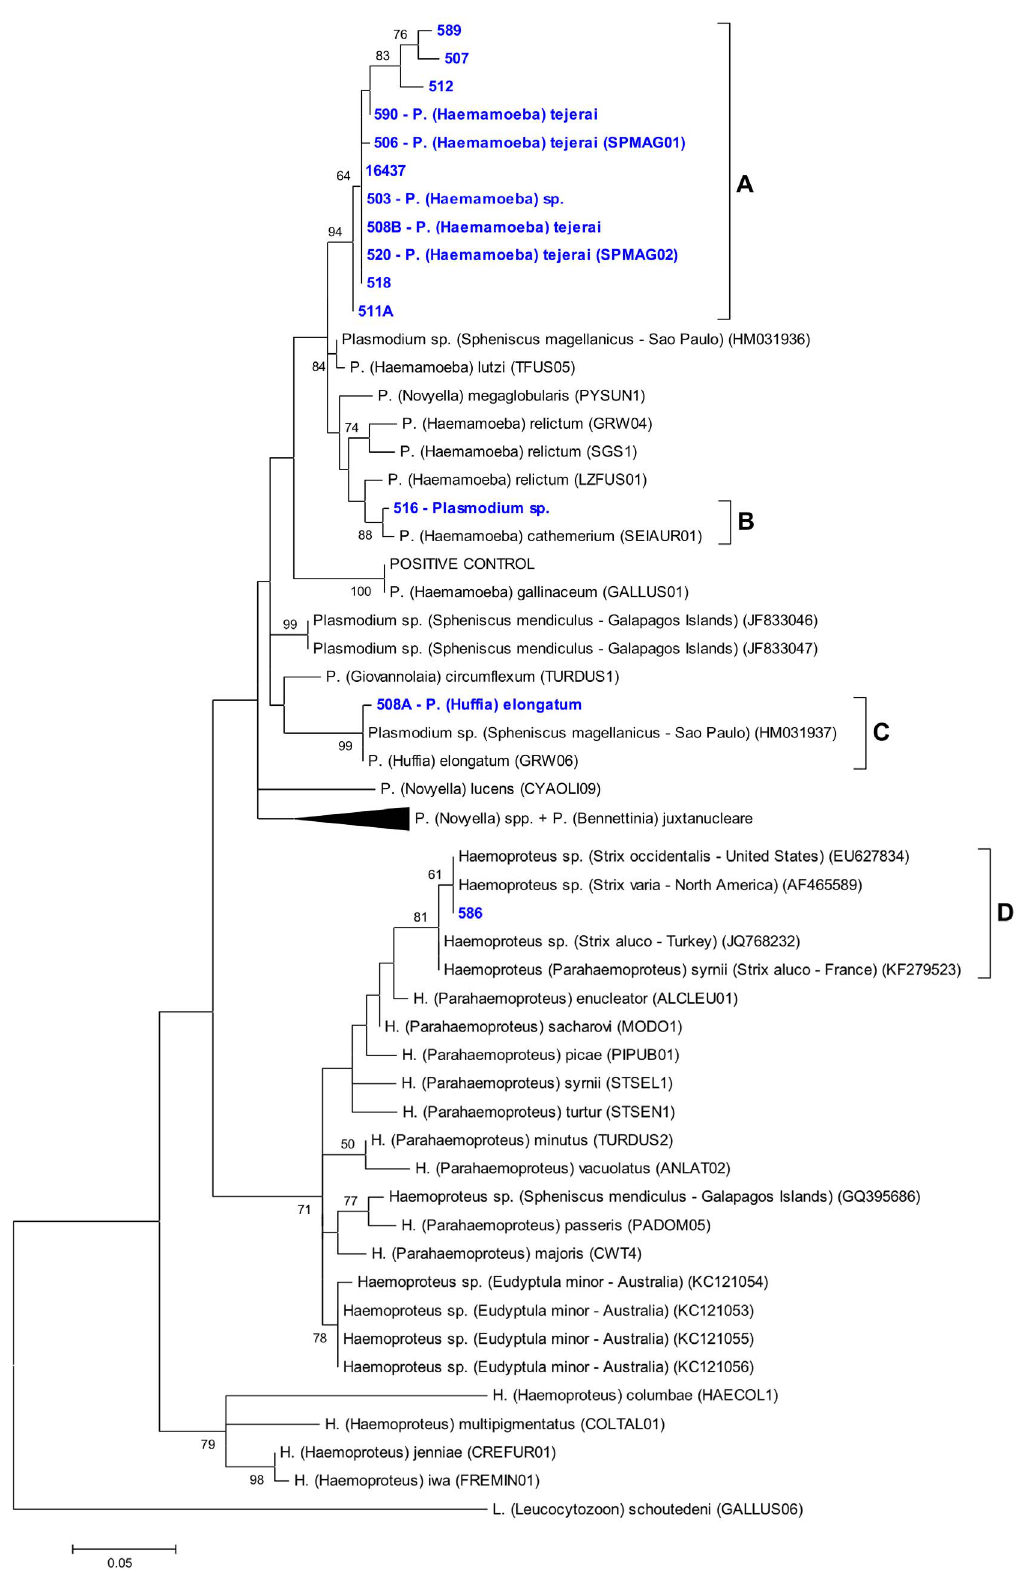
Figure 1. Maximum likelihood phylogenetic tree of the mitochondrial cytochrome b gene of the studied hemosporidian lineages. Lineages identified in this study are emphasized in blue. When available, information on the morphospecies observed on the corresponding blood smear is provided. Branch lengths are drawn proportionally to evolutionary distance (scale bar is shown). Lower bootstrap values ( , 50) are omitted.